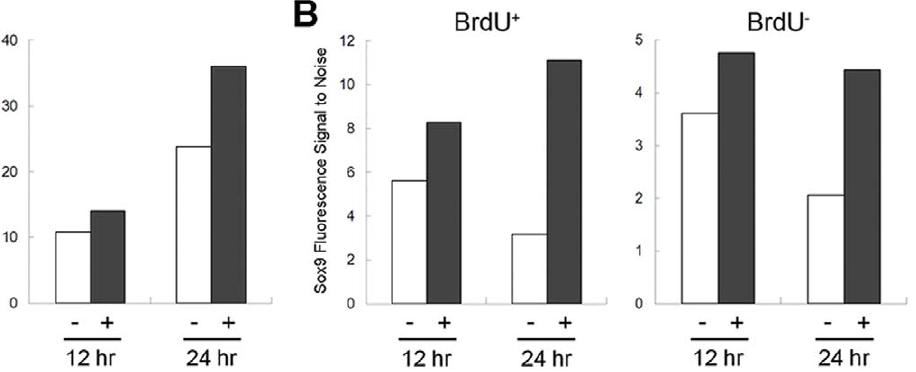
Figure 5. FGF-2 elevates Sox9 protein levels in both proliferating and non-proliferating hMSCs. Human MSCs were exposed to FGF-2 for 12 and 24 hours in the presence of BrdU, double-stained for Sox9 and BrdU, and analyzed using flow cytometry. (A) FGF-2 exposed hMSCs showed a higher percentage of BrdU + cells than non-FGF-2-exposed hMSCs after 12 and 24 hours. (B) Sox9 protein levels were elevated in both BrdU + and BrdU 2 FGF-2-exposed hMSCs after 12 and 24 hours, with BrdU + hMSCs showing more marked differences compared to non-FGF-2-exposed control hMSCs. Values are represented as fluorescence signal to noise ratios using geometric means.